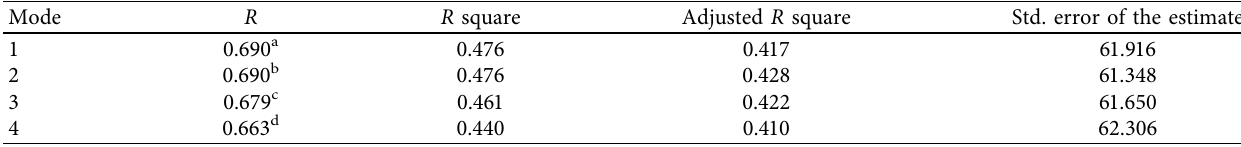
Table 4: Multiple linear regression model summary and overall fit statistics.